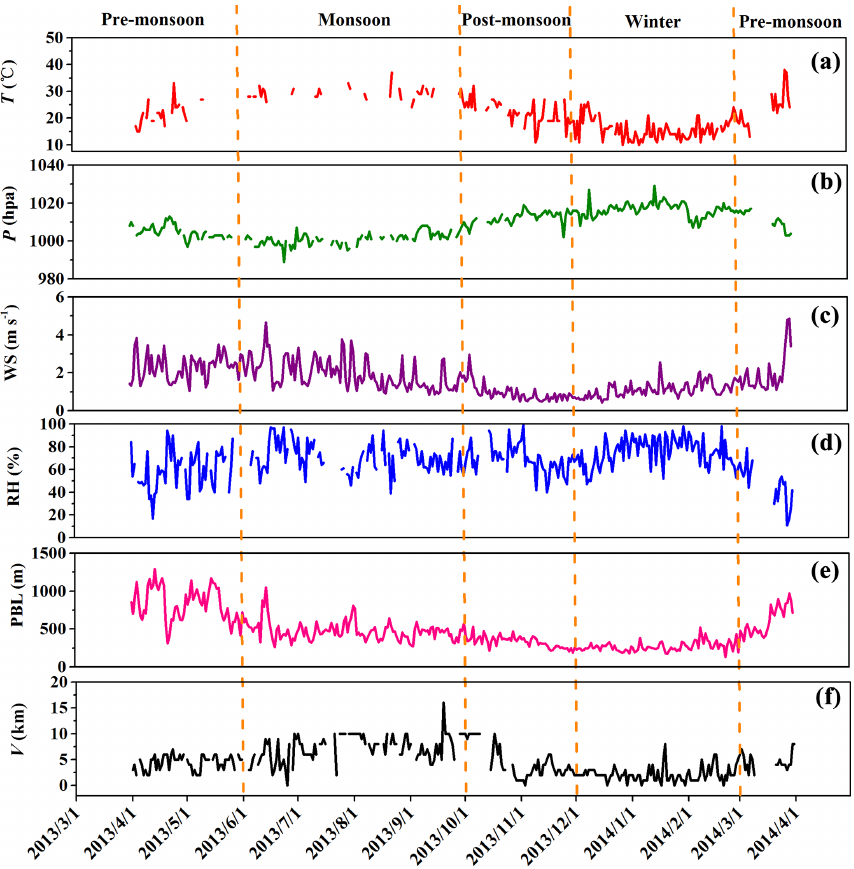
Figure 2. Time series of ambient temperature ( T ), atmospheric pressure ( P ), wind speed (WS), relative humidity (RH), planetary boundary layer (PBL) and visibility ( V ) at Lumbini from April 2013 to March 2014.